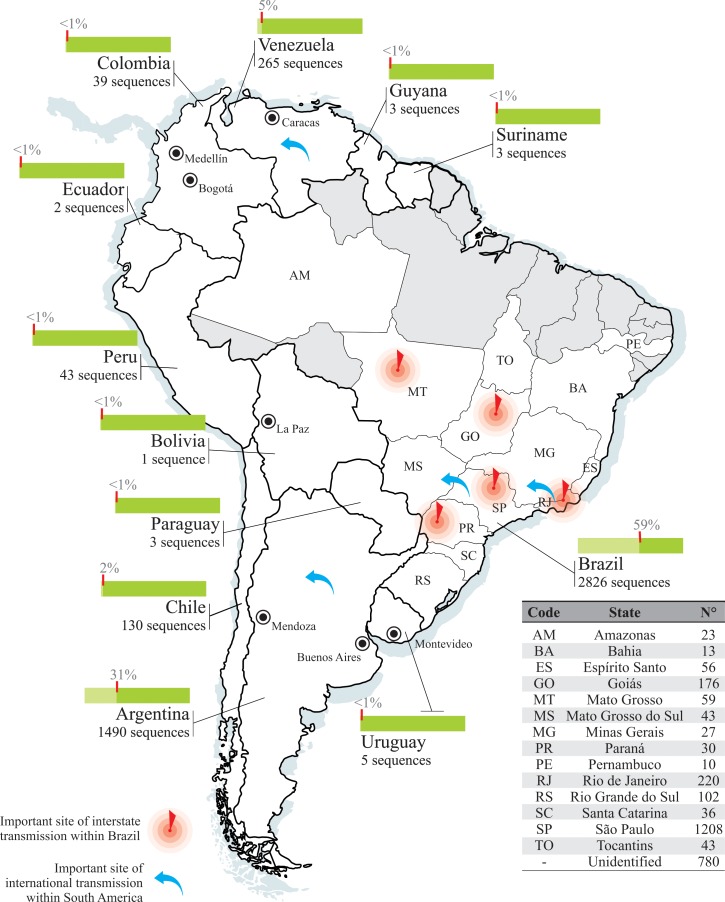
Geographic distribution and proportion of HIV-1 subtype B pol sequences from South American countries.Map shows locations of the HIV-1 subtype B sequences included in the dataset. The proportion (green bars) and the total number of sequences analyzed from each location is indicated. A compilation of all sequences from the Brazilian set and its respective state of sampling is indicated at the table included in the figure. Black dots indicate the cities sampled in this study. Sequences from Venezuela were sampled at Caracas (n = 213), from Colombia were sampled at Medellín (n = 32) and Bogotá (n = 7), the unique sequence from Bolivia was sampled at La Paz, sequences from Argentina were sampled at Mendoza (n = 2) and Buenos Aires (n = 1238), and sequences from Uruguay were sampled at Montevideo. For the rest of the countries the sequences had no identification of sampling region. Gray-shaded areas indicate regions not included in this study.